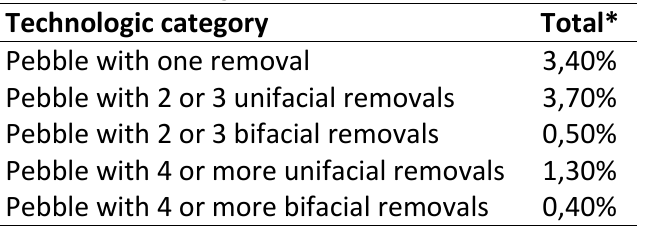
Table 3. Total percentage of worked pebbles and their removals.The total is in relation with the total percentage of the lithic